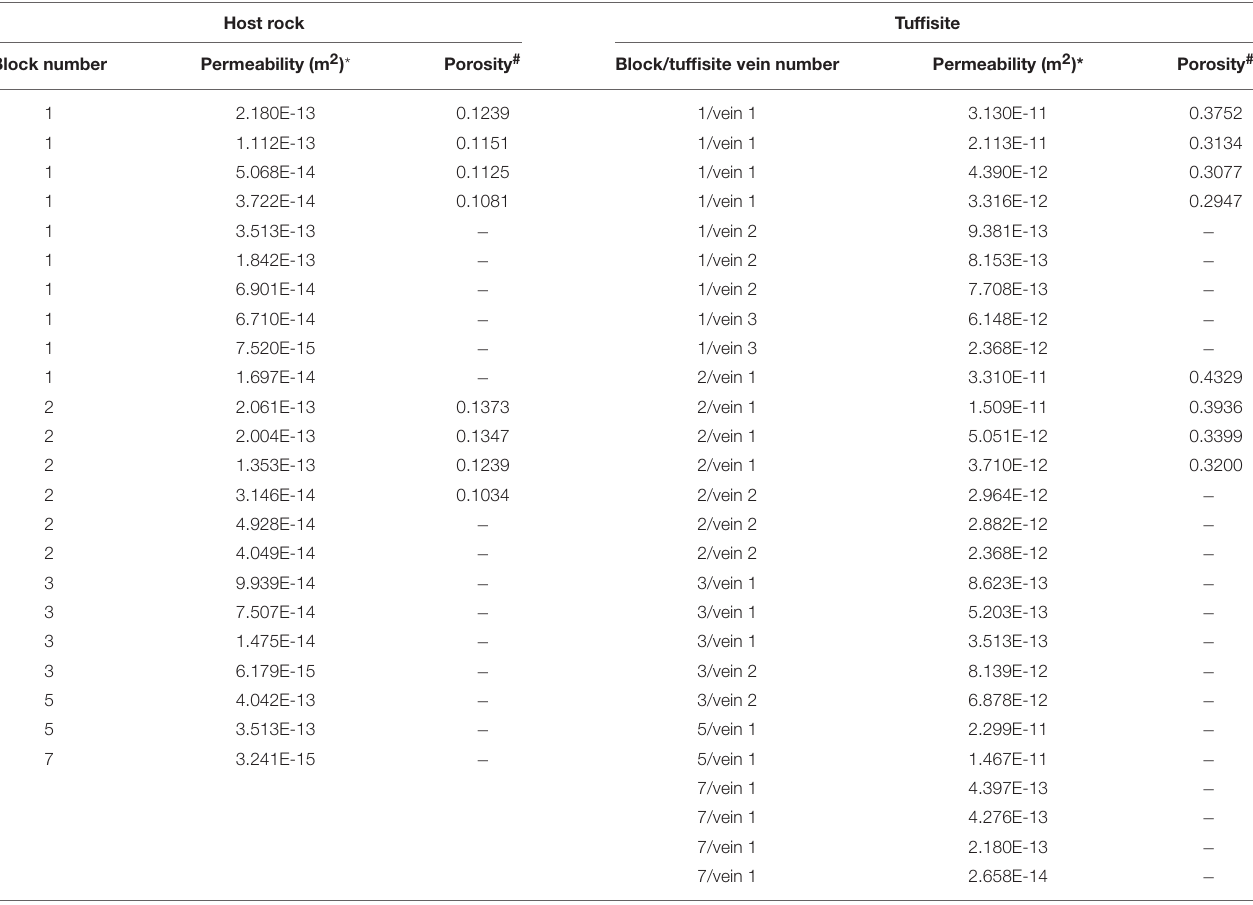
TABLE 1 | Measurements of natural host rock and tuffisite samples: Permeability measured by TinyPerm II minipermeameter for blocks 1, 2, 3, 5, and 7, with corresponding porosity measured by helium pycnometry for cores of 5mm (diameter) and 3–7mm (height) taken from blocks 1 and 2. Host rock Tuffisite Block number